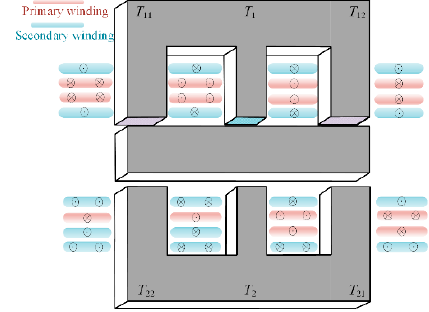
Figure 11. Integration scheme of CLTLC converter.